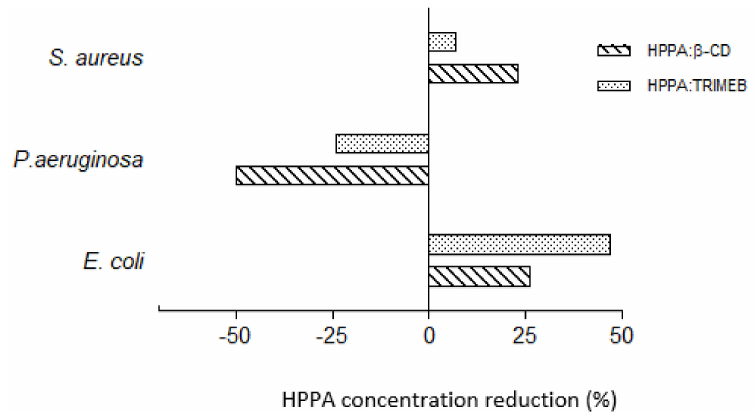
Figure 6. Bacterial growth inhibition: HPPA reduction percentages in KNDs on E. coli , P. aeruginosa , and S. aureus at 24 h of exposure to induce 50% of the bacterial growth